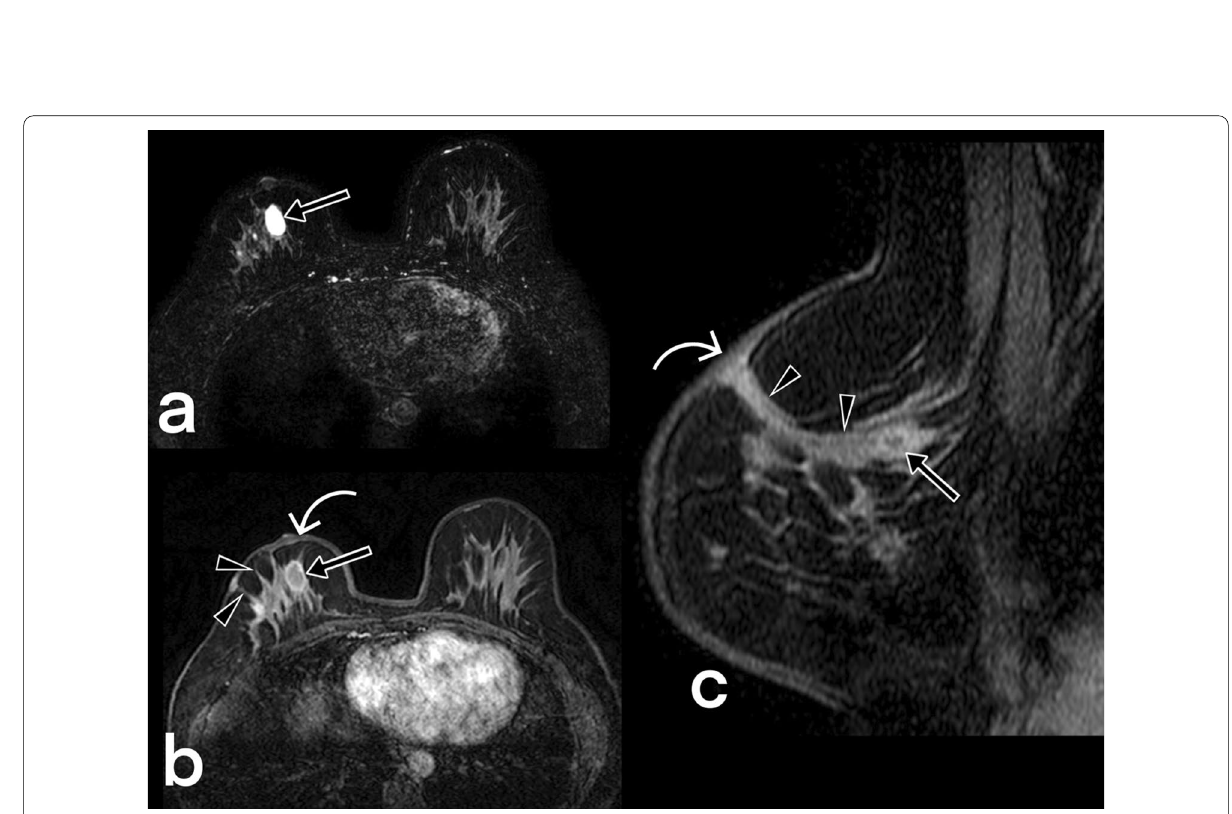
Fig. 12 MRI images of a 41-year-old female. Axial T2 weighted fat suppressed ( a ), fat-suppressed T1 weighted contrast-enhanced axial ( b ), and sagittal ( c ) images reveal cystic lesions (arrows) in the right breast with peripheral enhancement, compatible with an abscess that is fistulized (arrowheads) to the thickened skin (curved arrow). BIRADS